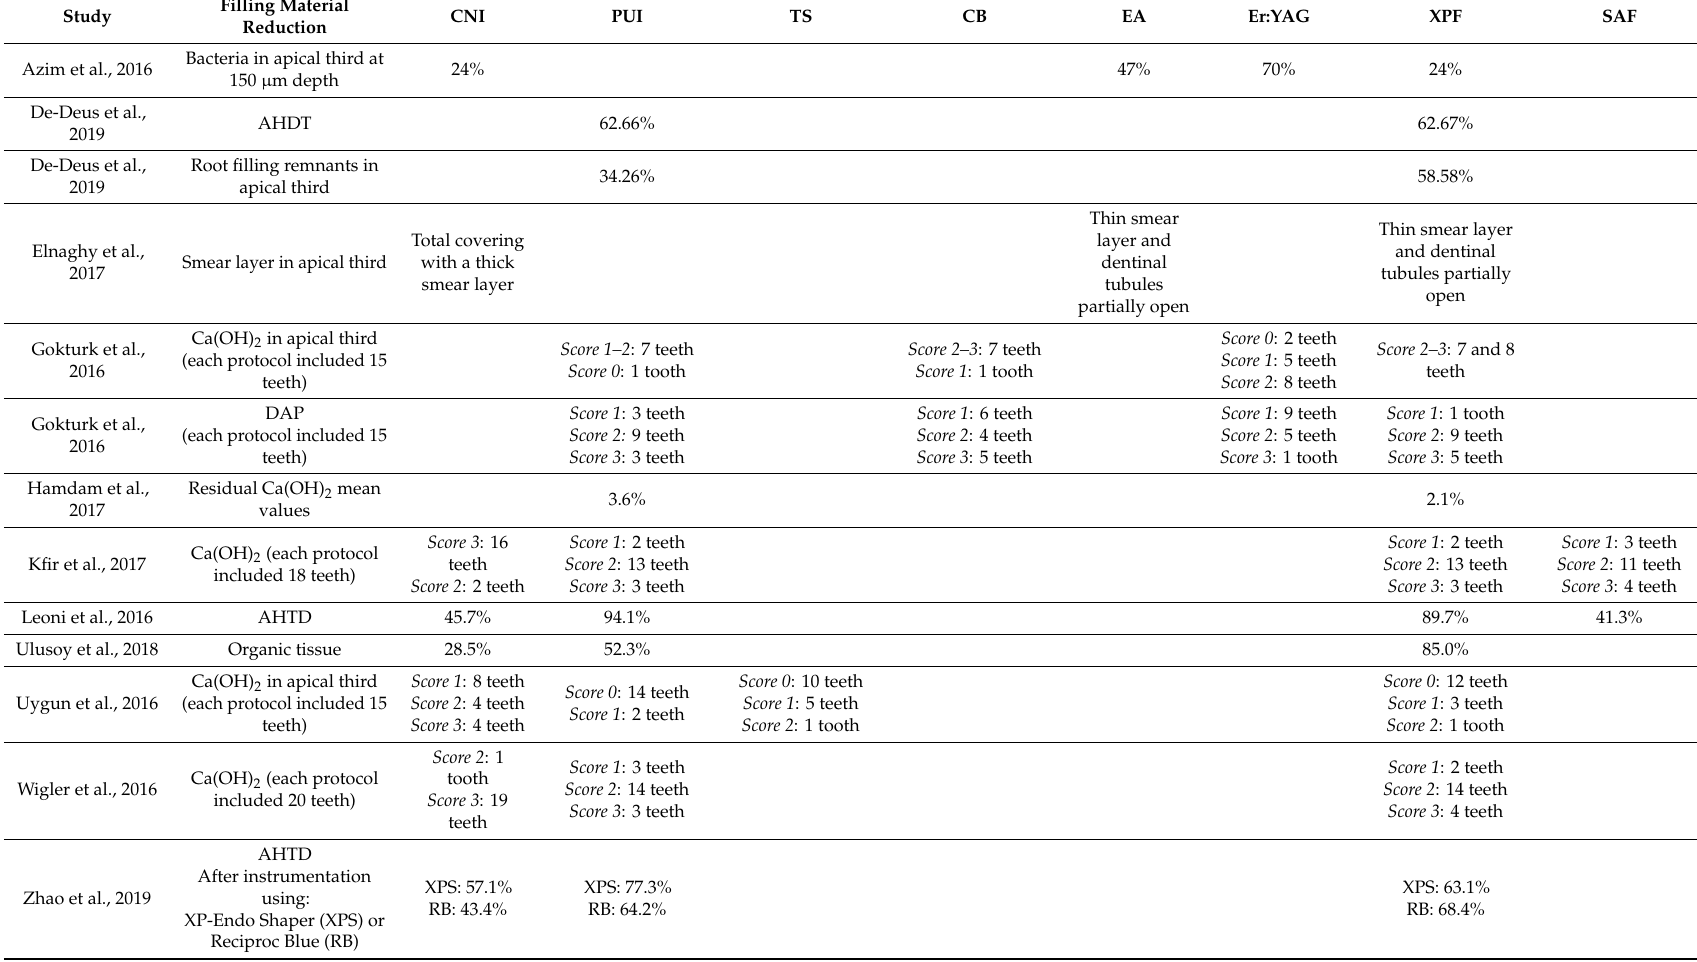
Table 3. Results of individual